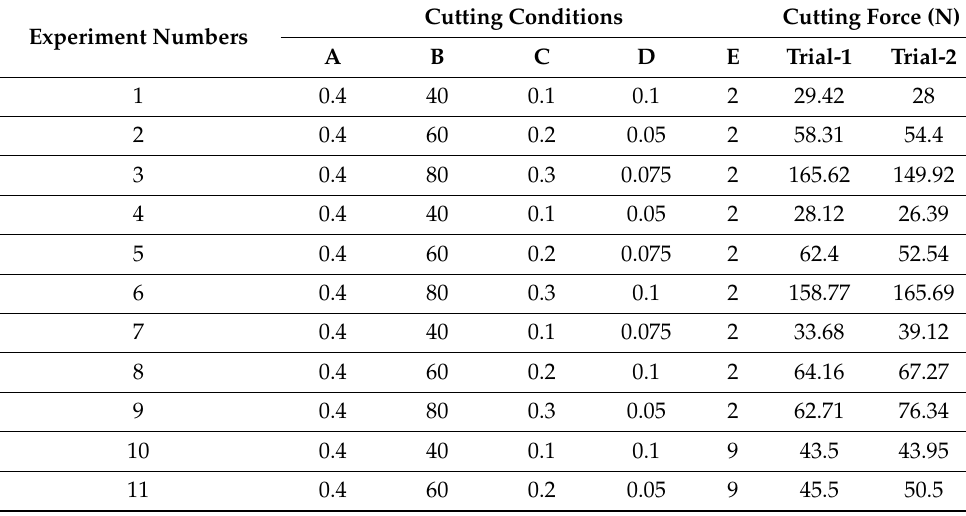
Table 5. Experimental results regarding cutting force ( F c